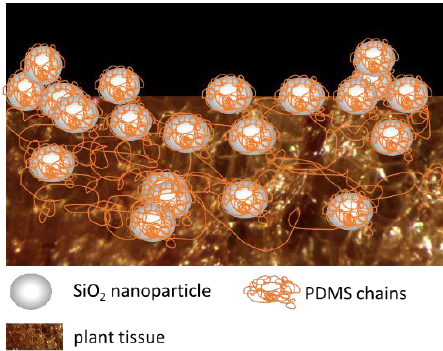
Figure 2. Visualization of the distribution of silica nanoparticles onto the PDMS (polydimethylsiloxane)-coated pith.